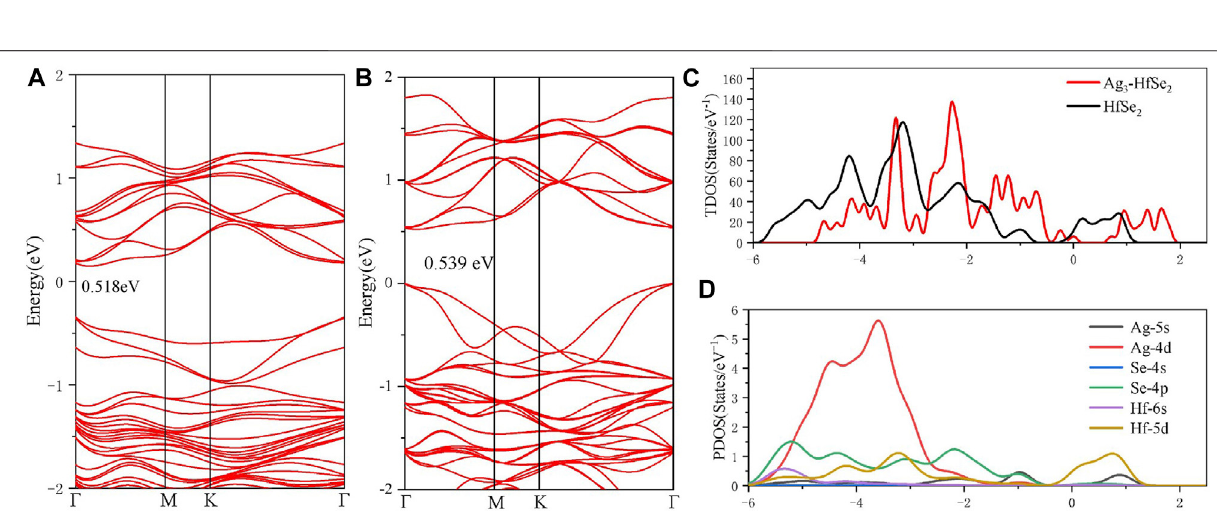
Frontiers in Chemistry |